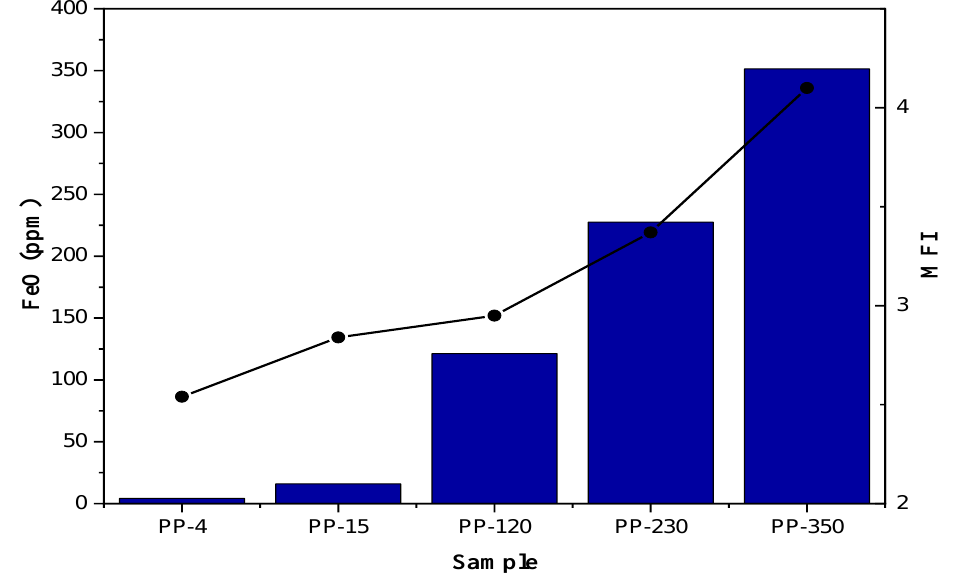
Figure 1. The relationship between the concentration of iron oxide and the MFI of PP.